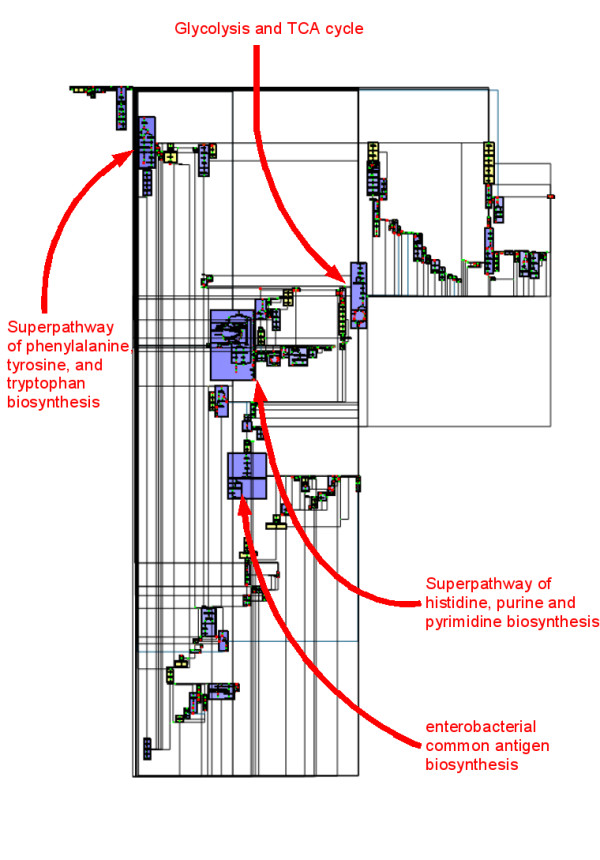
Whole metabolic network of E. coli drawn by MetaViz. The metanodes in purple represent metabolic pathways completely drawn. The metanodes in yellow correspond to specific structural schemes (chains or cycles) found by MetaViz.